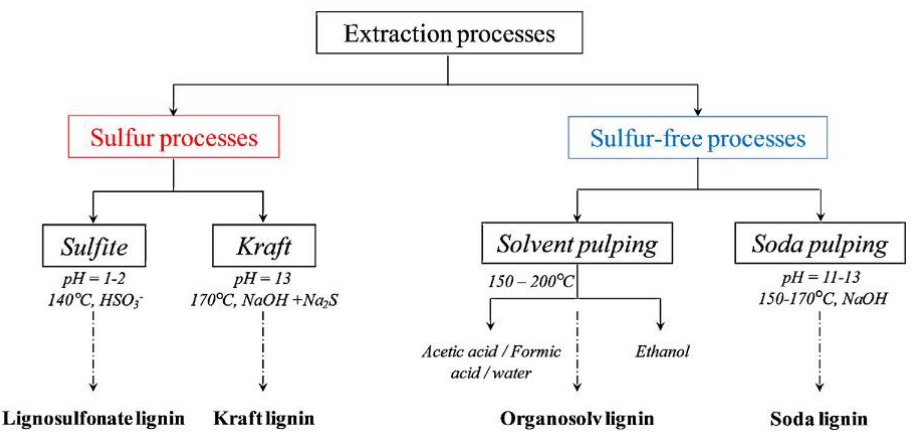
Figure 2. The processes of lignin extraction from lignocellulosic biomass and the respective types of technical lignin. Reproduced from [9], with the permission of Elsevier.